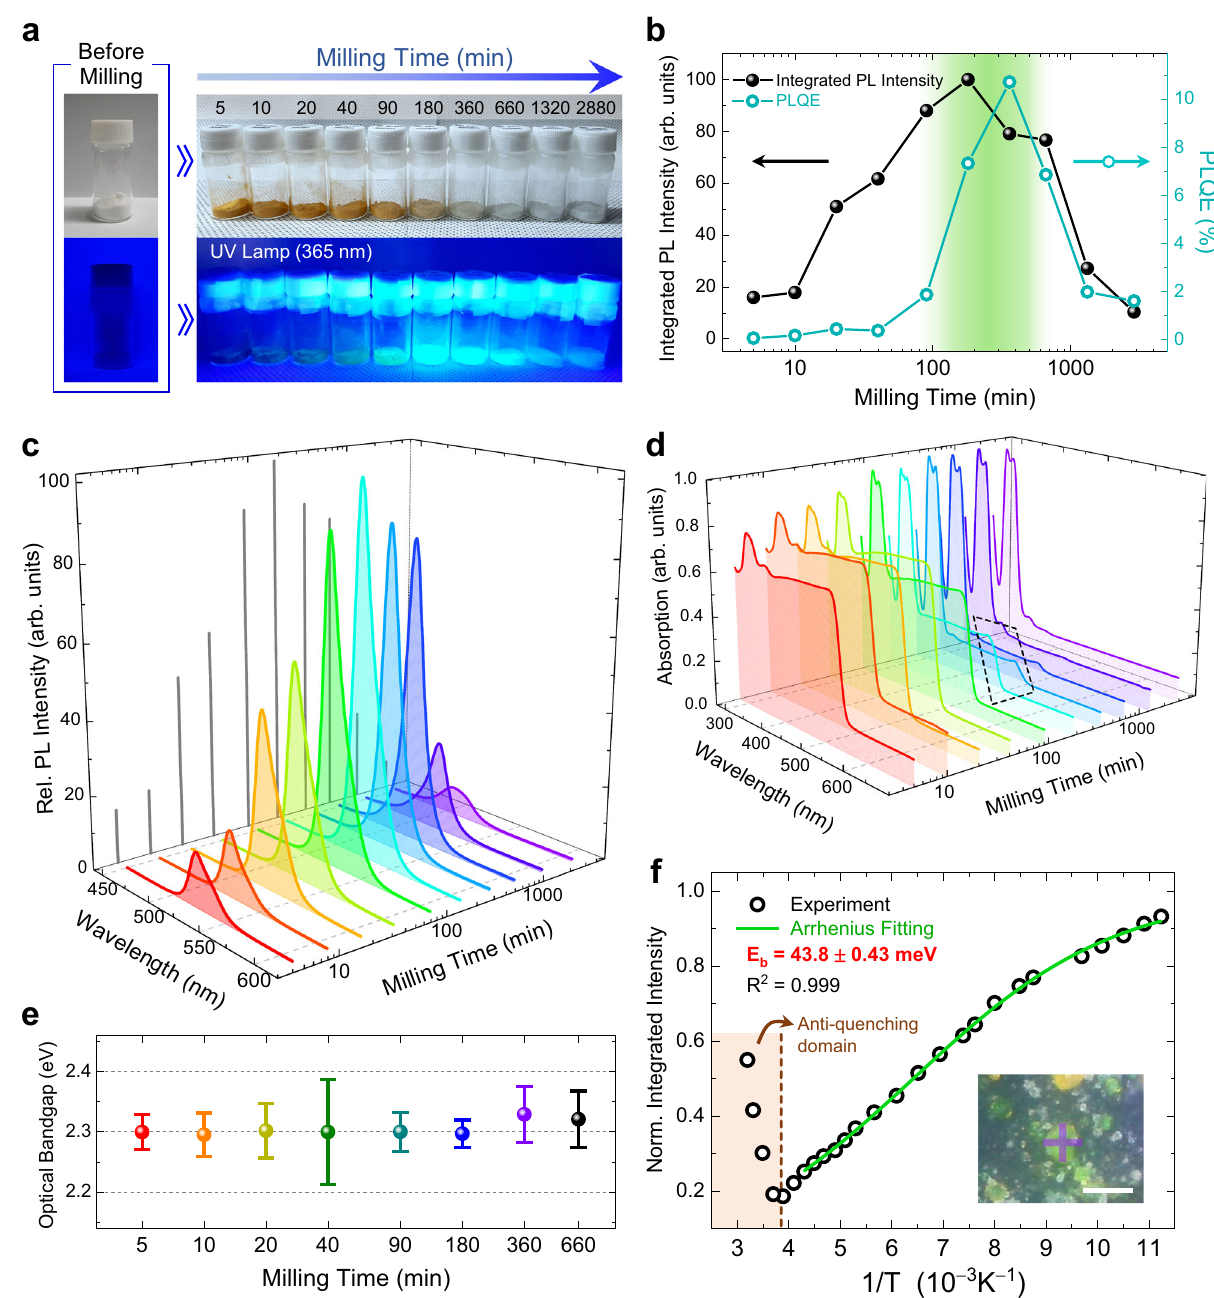
Fig. 2 Time evolution of optical properties and the origin of highly luminescent green emission during the MCS process. a Images of powder samples during the MCS process with successive increase in milling time. The samples show a gradual change in hue under ordinary fl uorescent (top) and in intensity under UV (bottom) lamps. b Time evolution of integrated PL intensity (solid black symbols) and PLQE (open cyan symbols) with an excitation wavelength of 365 nm. The green gradient marks the maximum region of both emission parameters. c Time evolution of PL spectra as milling time elapses with an excitation wavelength of 365 nm. The gray lines in the milling time – rel. PL intensity plane indicate the orthogonal projection of the PL spectra. d Time evolution of absorption spectra as milling time elapses. The dashed black box indicates the onset elevation difference between 180-min and 360- min samples near a wavelength of 532 nm. e Calculated optical bandgaps as a function of milling time. Values of optical bandgaps correspond to the absorption onsets of the Tauc plots 60 as shown in Supplementary Fig. 8. Error bars are derived from the deviations in linear fi tting. f Temperature- dependent integrated PL intensity of the green emissive region in the 90-min sample (one of the intermediate-stage samples with high intensity green emission) under a 405-nm laser excitation source. The inset shows an optical image of the target scene with laser collimation marked in semi-transparent purple cross. Scale bar, 20 μ m. Source data are provided as a Source Data fi